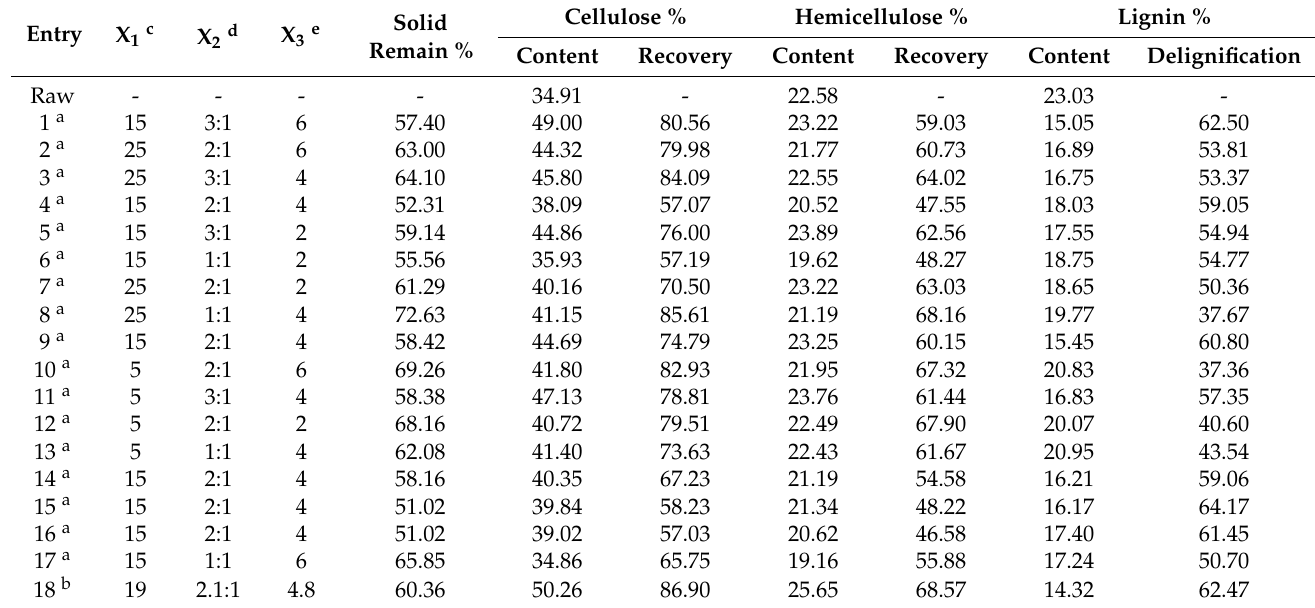
Table 1. Compositional analysis of wheat straw using ammonia–mechanical